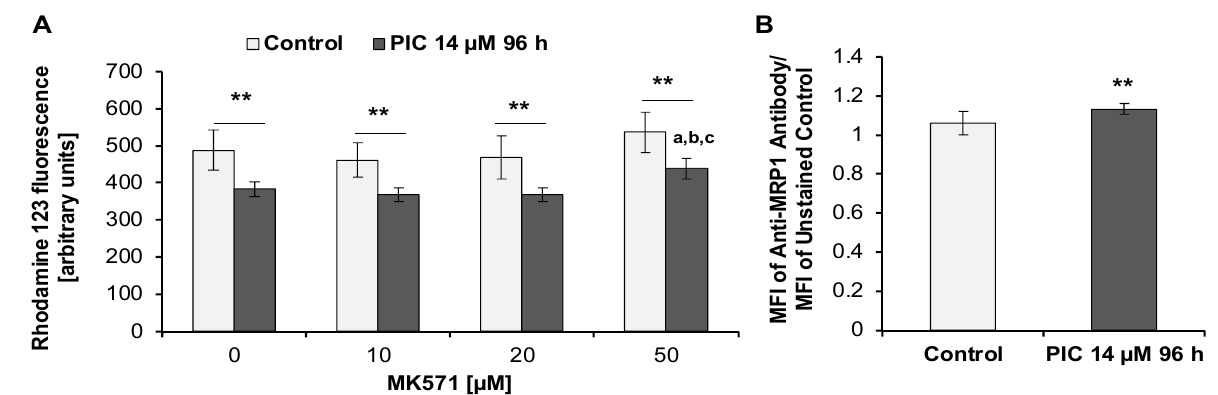
Figure 8. Detection of MRP1 in HL-60 cells. Cells were incubated with piceatannol (PIC, IC 90 = 14 µM) for 96 h. ( A) MRP1 activity analysis (flow cytometry analysis). Rhodamine 123 uptake/retention assay was performed in the presence and absence of MK571. Data are presented as means ± SD of three independent experiments in duplicates. ** p < 0.01, statistically significant differences between piceatannol-treated cells and untreated cells, both incubated in the absence or presence of MK571. a p < 0.001, statistically significant differences compared to piceatannol-treated cells incubated without MK571; b p < 0.001, statistically significant differences compared to piceatannol-treated cells incubated with 10 µM MK571; c p < 0.001, statistically significant differences compared to piceatannol-treated cells incubated with 20 µM MK571 (One-way ANOVA, Tukey’s post hoc analysis). ( B) Expression of MRP1 in HL-60 cells. Control (untreated cells) and piceatannol-treated cells were stained with anti-MRP1 (QCRL-3) antibody (flow cytometry analysis). Data are presented as means ± SD of three independent experiments in duplicates. (Student’s t -test).